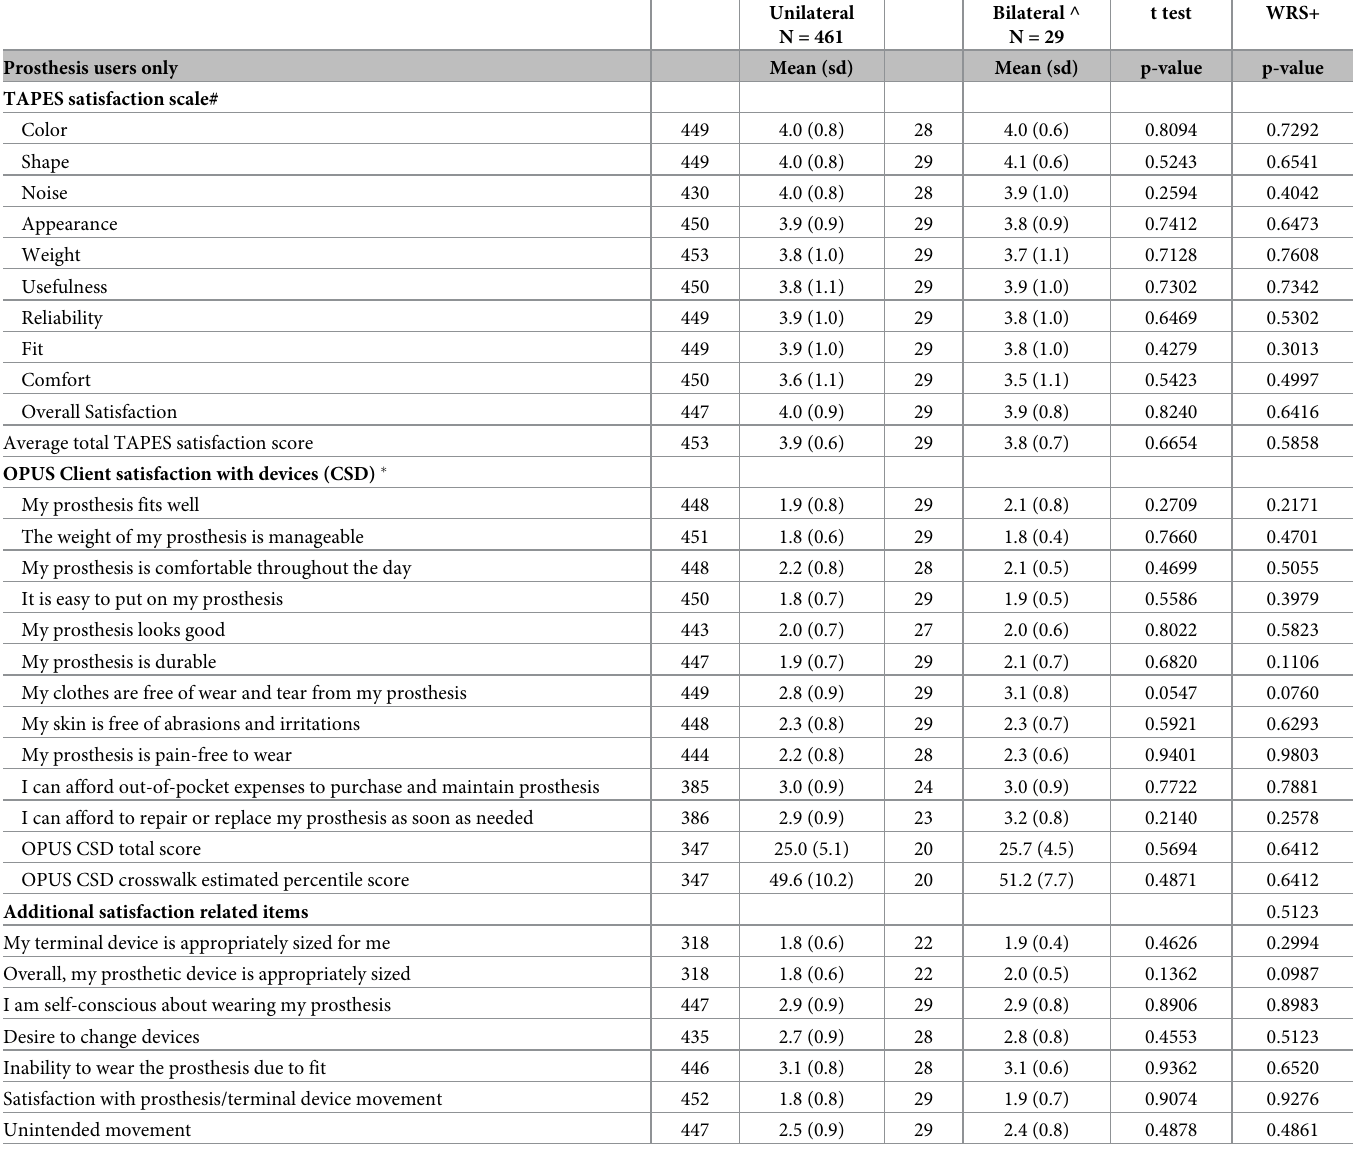
Table 5. Satisfaction with primary prosthesis (prosthesis users